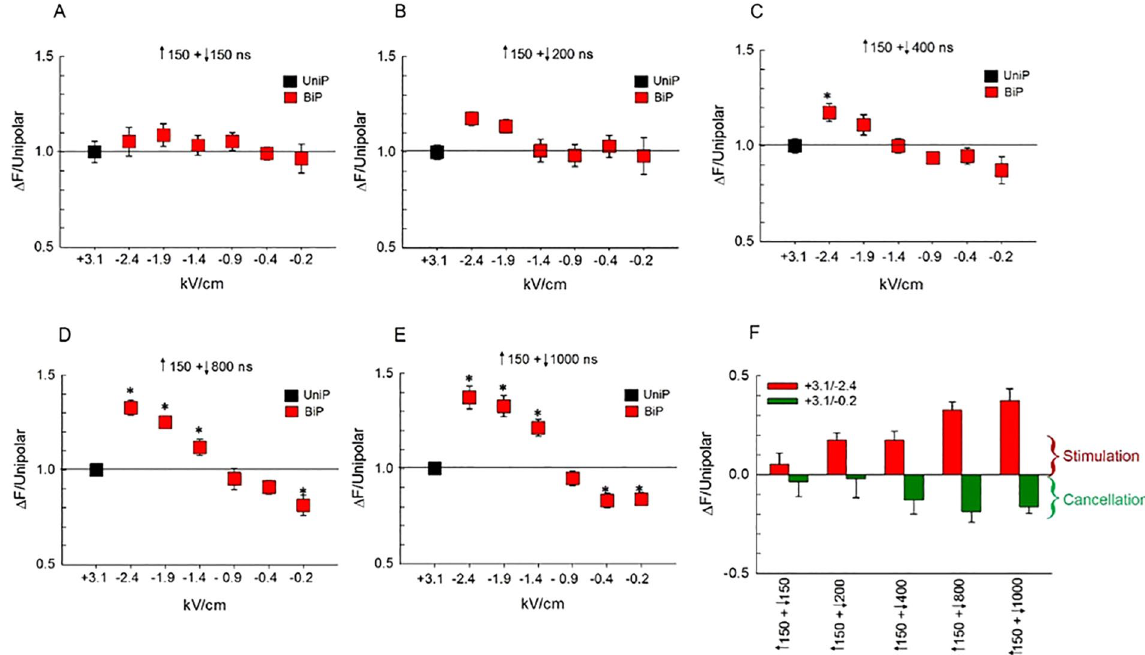
Figure 7. Effect of simultaneously decreasing the amplitude and increasing the duration of the negative phase of a bipolar pulse on [Ca 2 + ] i . For panels (A–E), the amplitude of Ca 2 + transients (mean ± s.e.m.) triggered by bipolar pulses was normalized to that elicited by a 150 ns unipolar pulse (n = 6–9) set to an E-field of 3.1 kV/ cm, and plotted as a function of the E-field amplitude of the negative pulse (represented as negative values). Pulse duration combinations were as follows: ( A ) ↑ 150 + ↓ 150 ns (n = 7–9), ( B ) ↑ 150 + ↓ 200 ns (n = 5–9), ( C ) ↑ 150 + ↓ 400 ns (n = 6–11), ( D ) ↑ 150 + ↓ 800 ns (n = 10–16) and ( E ) ↑ 150 + ↓ 1000 ns (n = 7–12). ( F ) Bar graph showing the mean ± s.e.m. for the maximal increase (Stimulation) or decrease (Cancellation) in the amplitude of the Ca 2 + transients for the responses shown in ( A – E ) relative to that elicited by a 150 ns unipolar pulse. The E-field of the negative phase of the pulse was either 2.4 or 0.2 kV/cm. * p < 0.05, significantly different from corresponding 150 ns unipolar pulse.